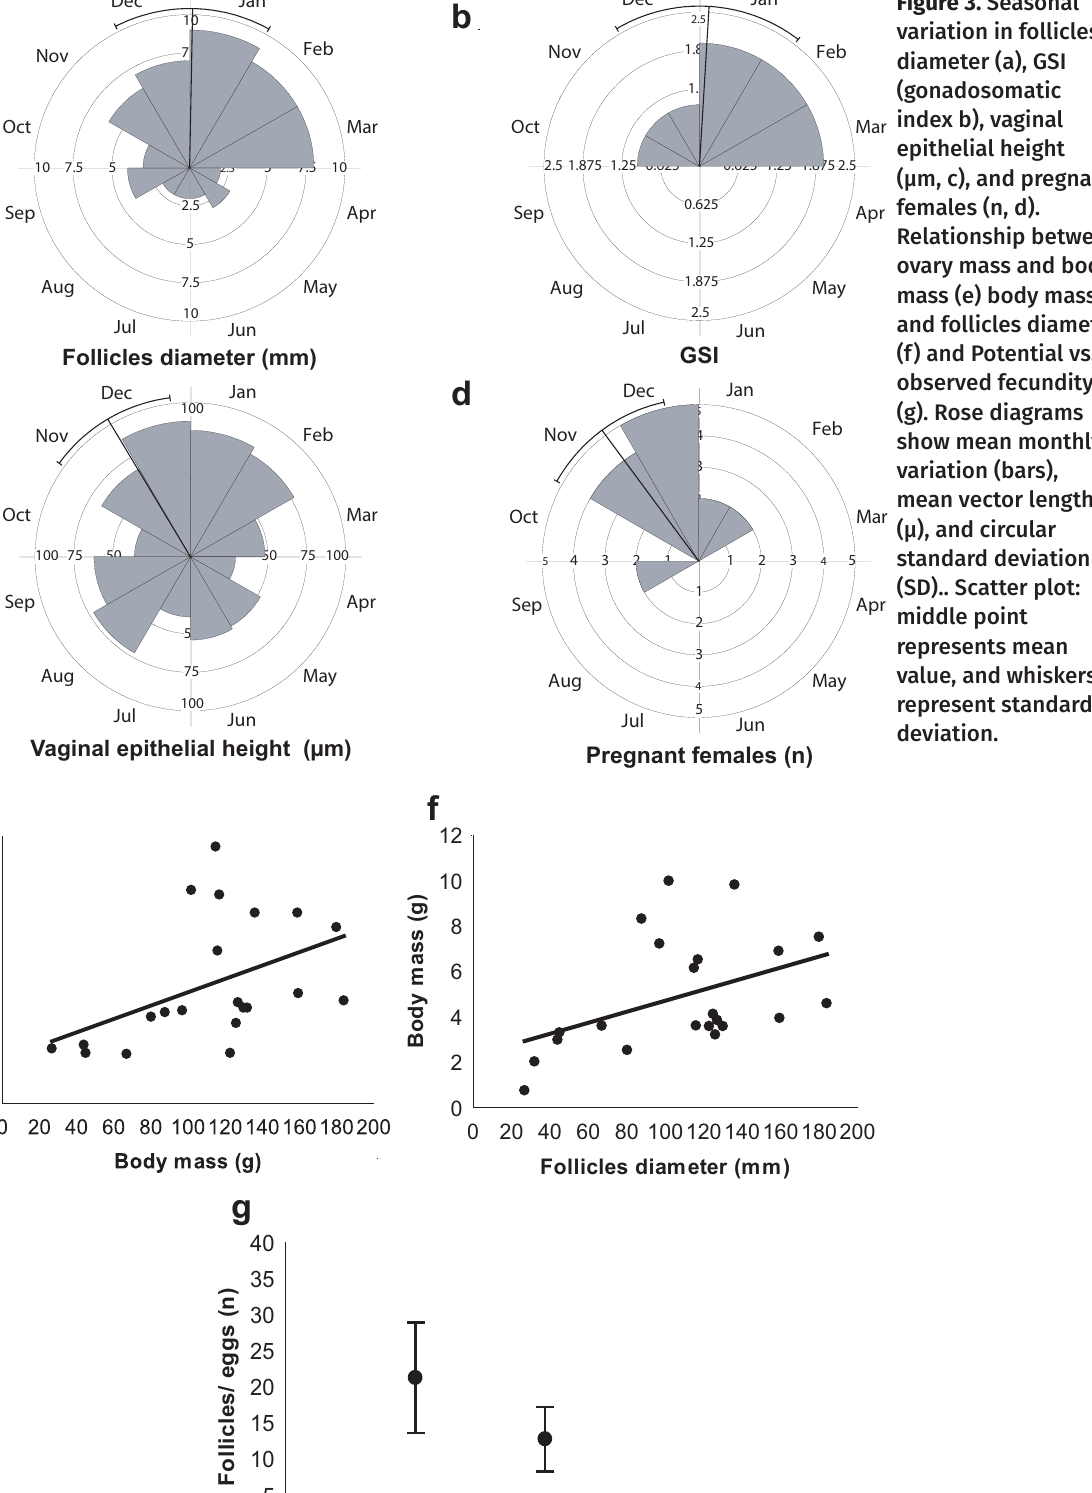
(g). Rose diagrams show mean monthly variation (bars), mean vector length (µ), and circular standard deviation (SD).. Scatter plot: middle point represents mean value, and whiskers represent standard